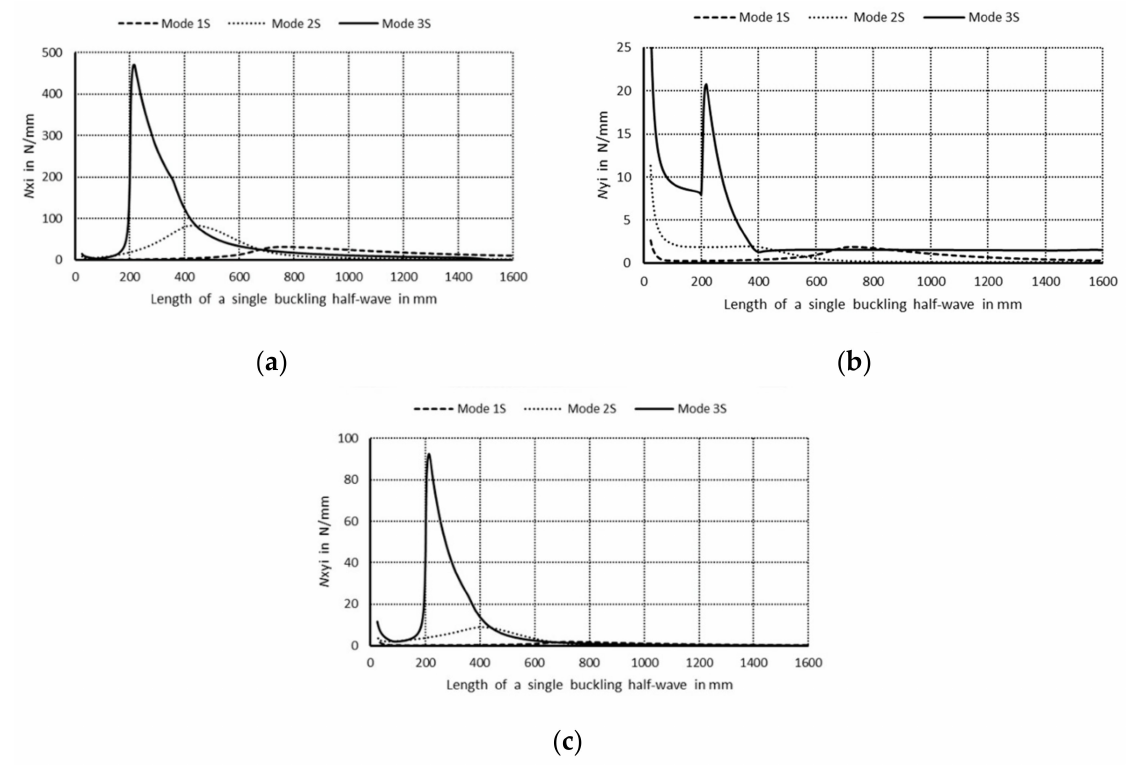
Figure 4. Maximal absolute values of membrane forces in N/mm for symmetrical buckling modes: ( a ) longitudinal forces N xi , ( b ) transverse forces N yi , and ( c ) shear forces N xyi as a function of the length of a single buckling half-wave in mm.